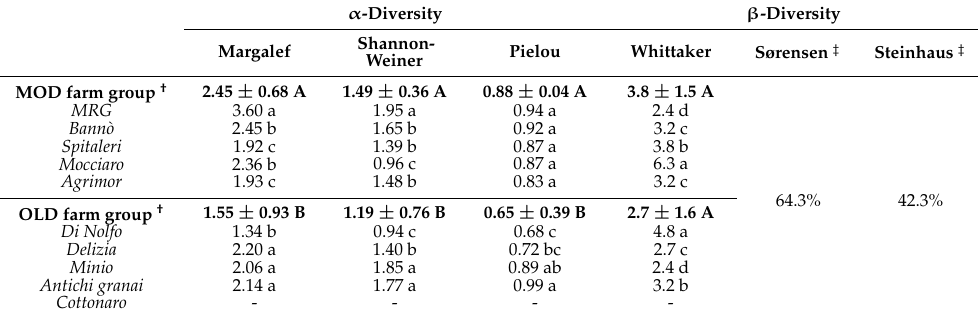
Table 4. α - and β -diversity indices of weed species in the real flora across the 10 farms under study. α -Diversity β -Diversity